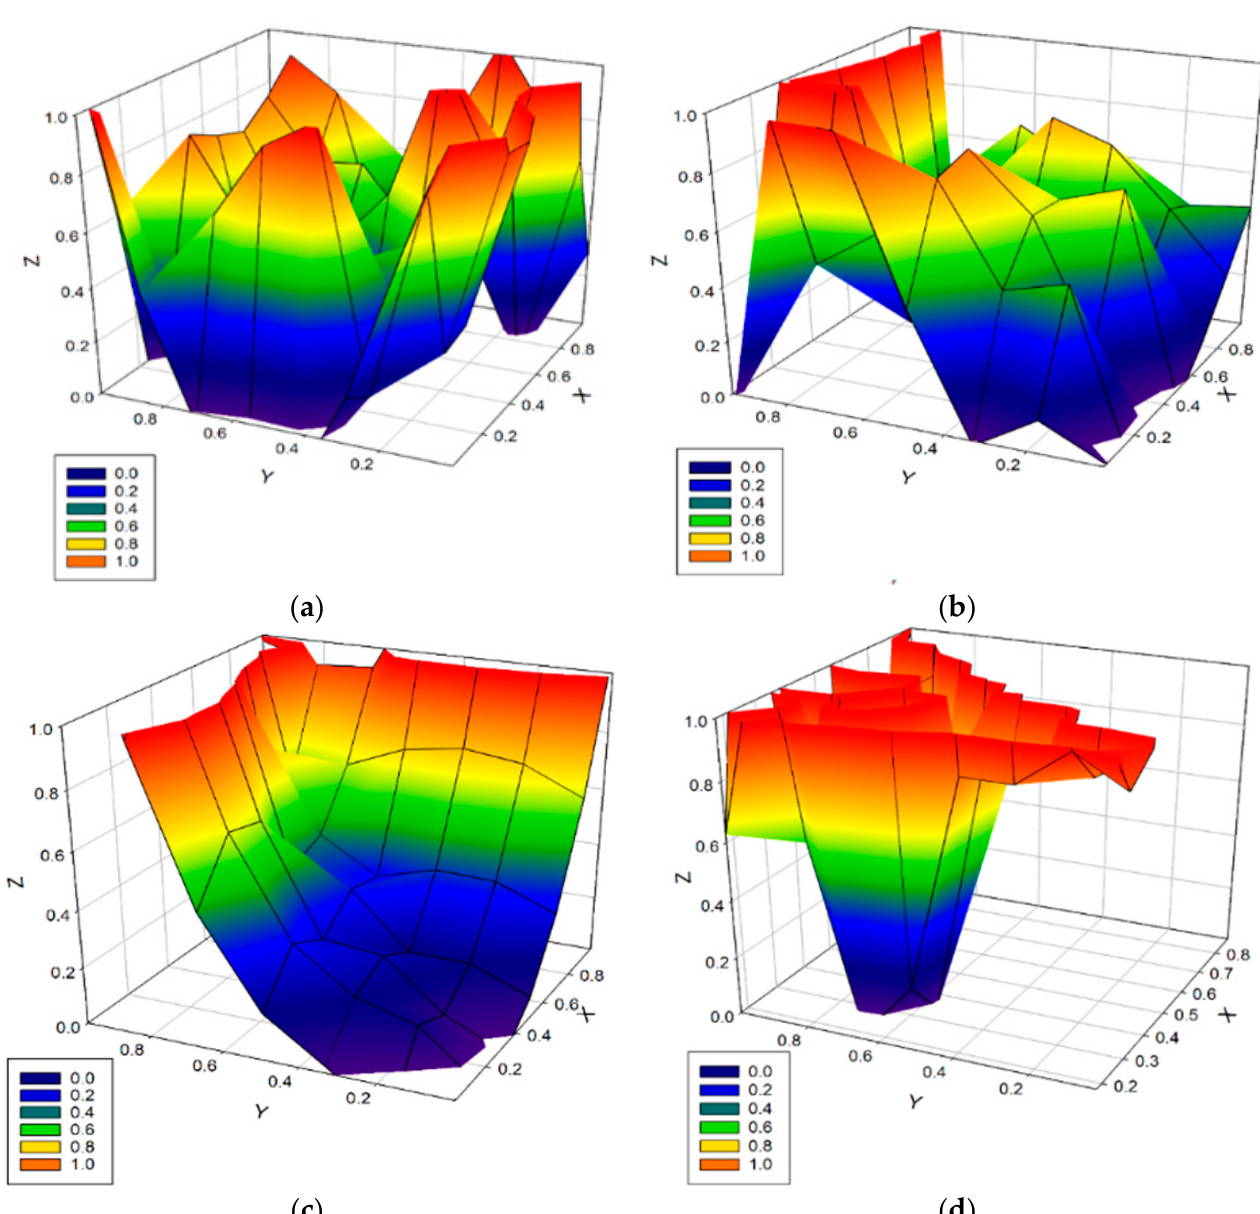
Figure 13. ( a ) shows spread of gain function; ( b ) shows the progress of the PTIP as the number of errors decreases; ( c ) displays the evolution of turning process; and ( d ) shows the error optimiza- tion process.